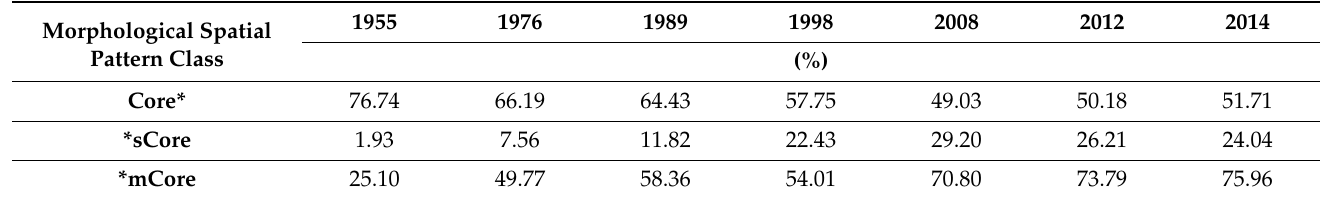
Table 5. The relative importance of each morphological spatial pattern class expressed as a percentage of the total foreground area analysed for each of the years